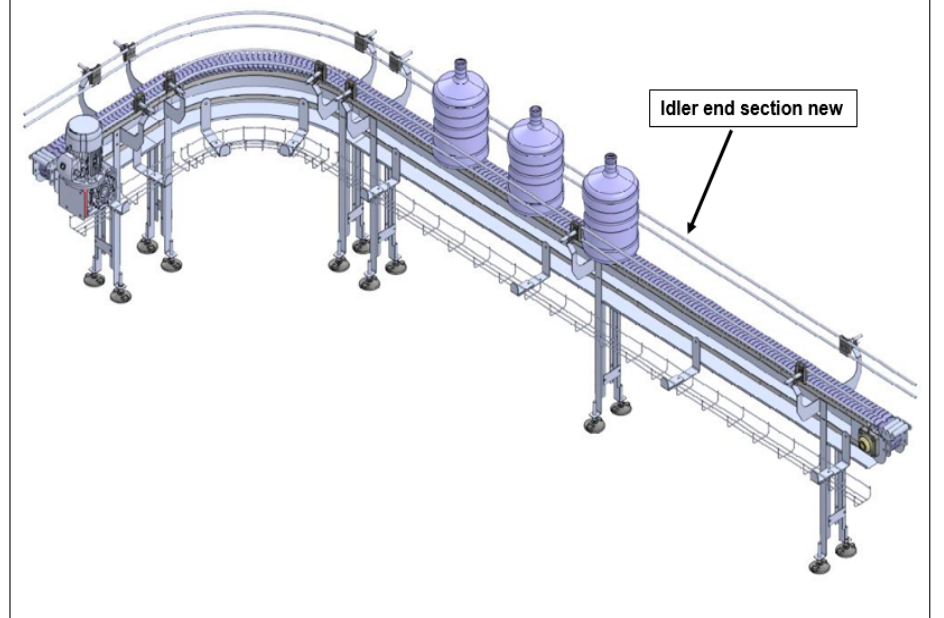
Figure 13. CAD model representing the new conveyor design.